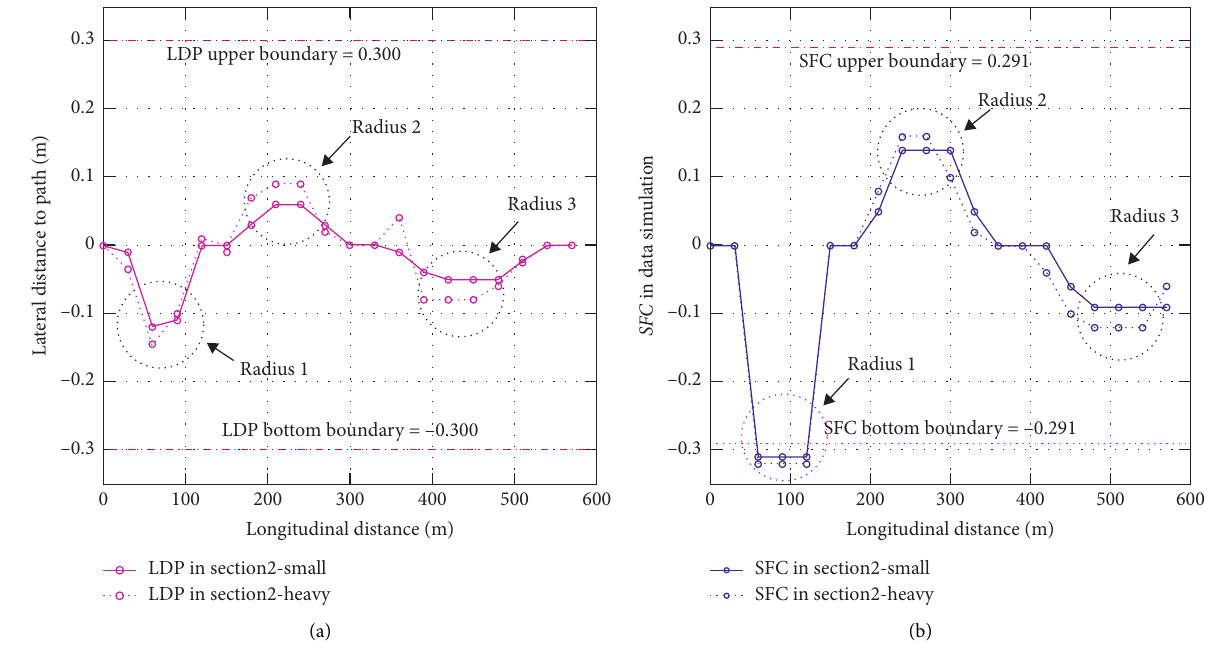
Figure 9: The simulation results of Section 2. (a) Lateral Distance Path Change Trend. (b) SFC Change Trend.